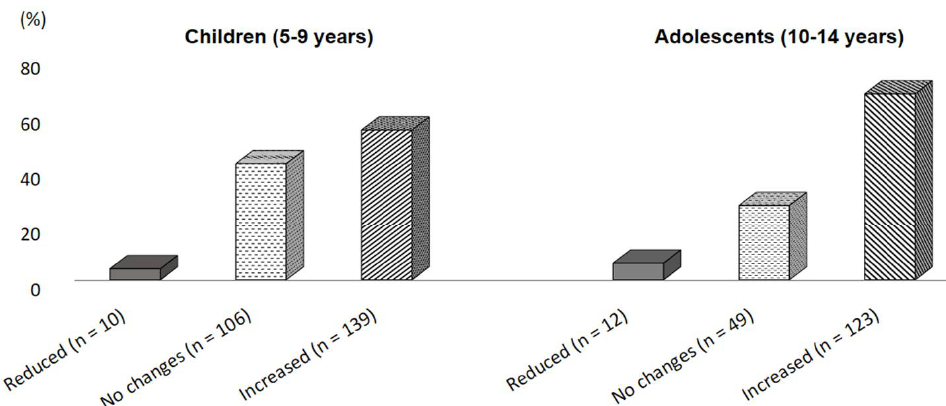
Figure 1. Proportion of the population who changed in body weight during the first lockdown, according to age group.